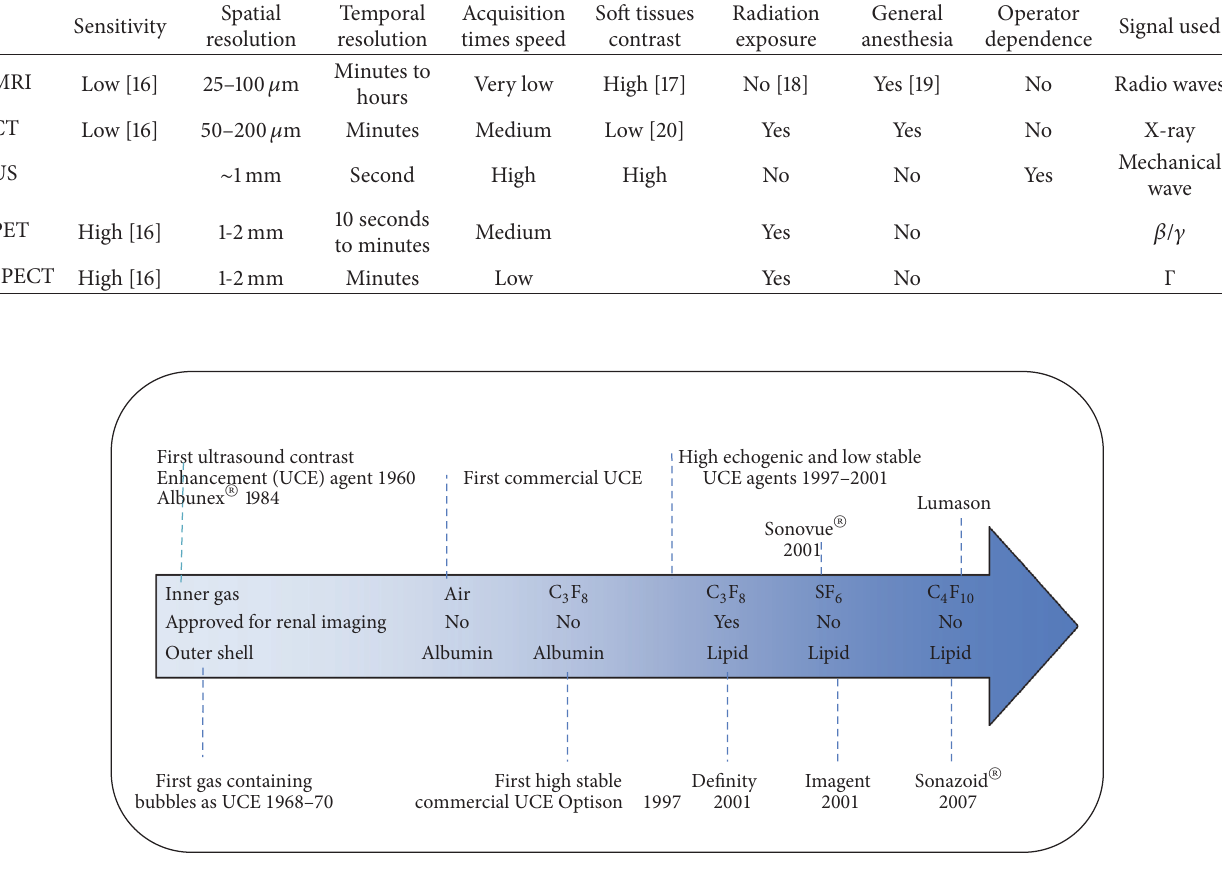
Figure 1: The timeline of development of US-based contrast agents.